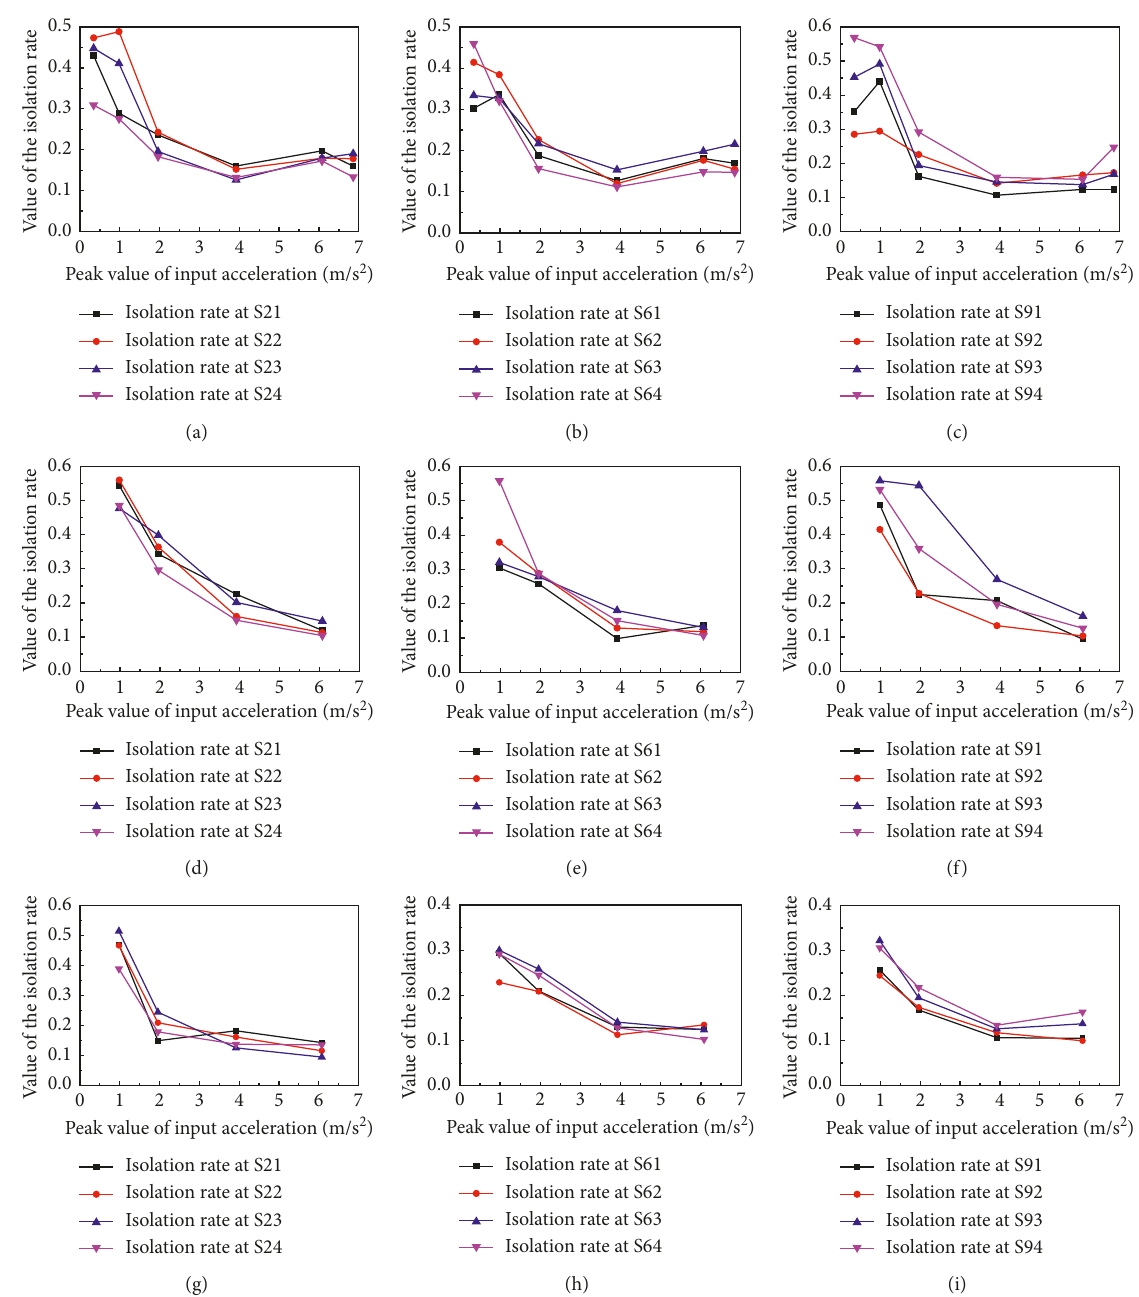
Figure 14: Vibration isolation rate of stress. (a) S2 under Taft seismic motion; (b) S6 under Taft seismic motion; (c) S9 under Taft seismic motion; (d) S2 under 311 seismic motion; (e) S6 under 311 seismic motion; (f) S9 under 311 seismic motion; (g) S2 under Lsfx seismic motion; (h) S6 under Lsfx seismic motion; (i) S9 under Lsfx seismic